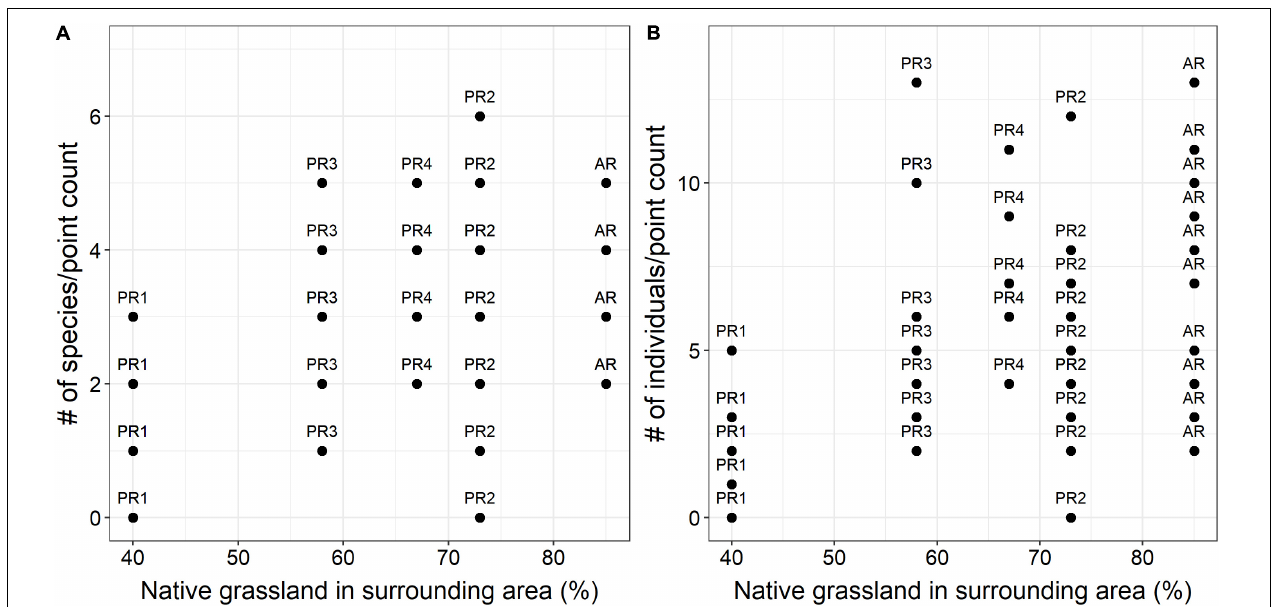
FIGURE 1 | Species richness (A) and abundance (B) of grassland birds relative to the amount of native grassland in the